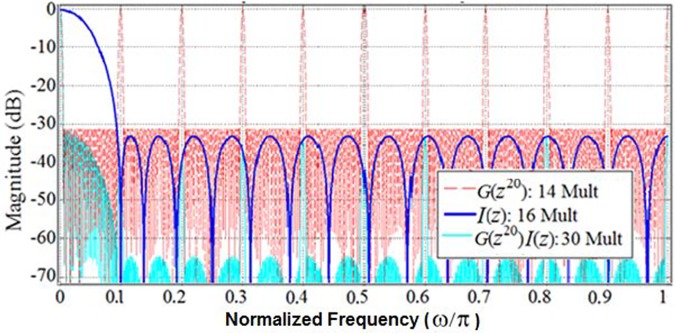
Magnitude responses (dB) of IFIR components of UPartial(z): G(z20) and I(z).